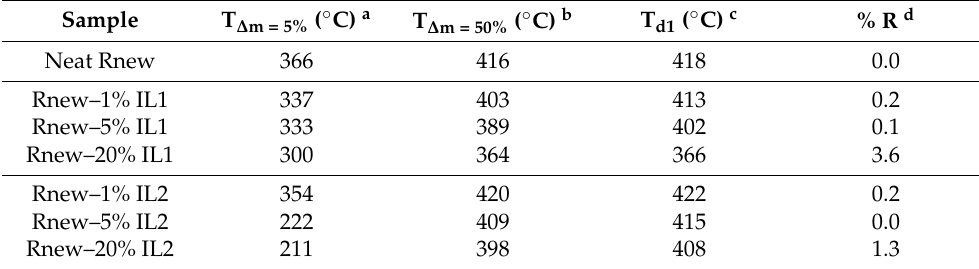
Figure 4. DTGA thermograms for Pebax ® Rnew and Pebax ® Rnew composite membranes. ( A ) Samples containing IL1 (HdmimDMSIP); ( B ) Samples containing IL2 (OOMmimPF 6 ). Table 1. Thermogravimetric data of neat Pebax ® Rnew and its ILs